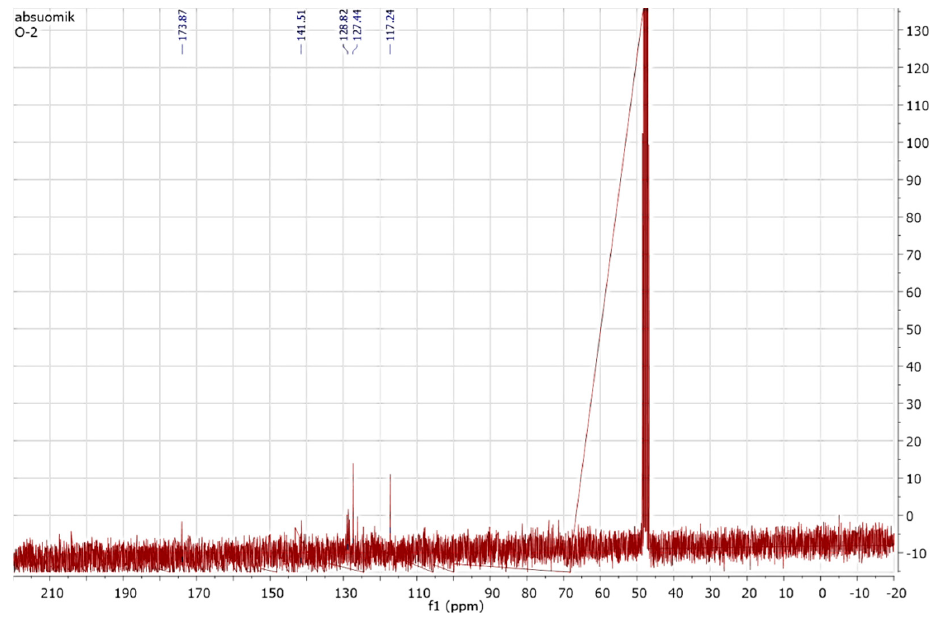
Figure 10. 13 C NMR of the original dye, orange II.